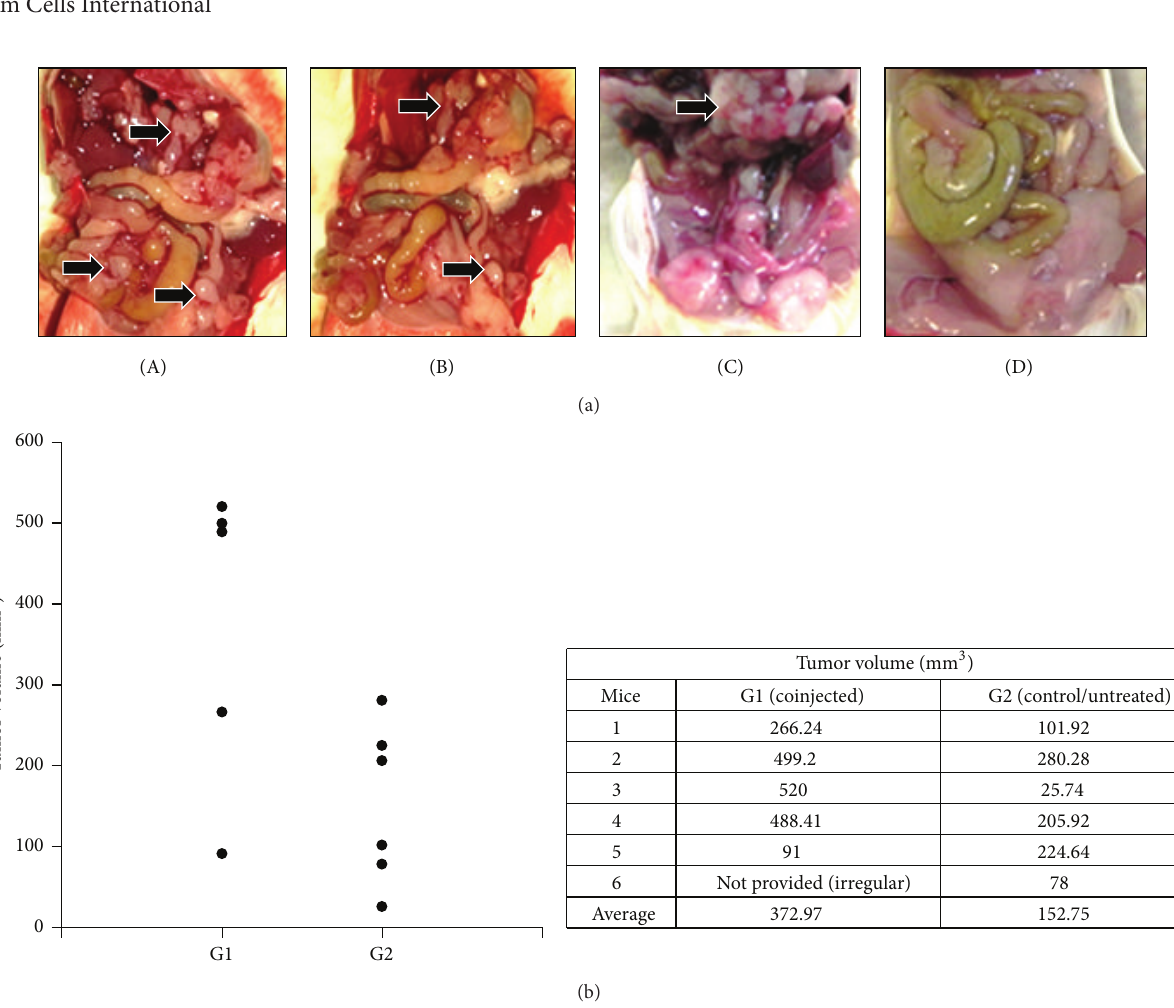
Figure 2: Coinjected group necropsy and tumor growth analysis. (a) Abdominal view of coinjected animals (A, B, and C) and untreated control (D), on day 15. Arrows indicate probable tumor nodules. One representative animal of each group is shown. (b) Primary tumor volume at death (day 15), showing that coinjected animals (G1) presented, on average, primary tumor volumes about 2.4x higher than the untreated group (G2). Animals are represented